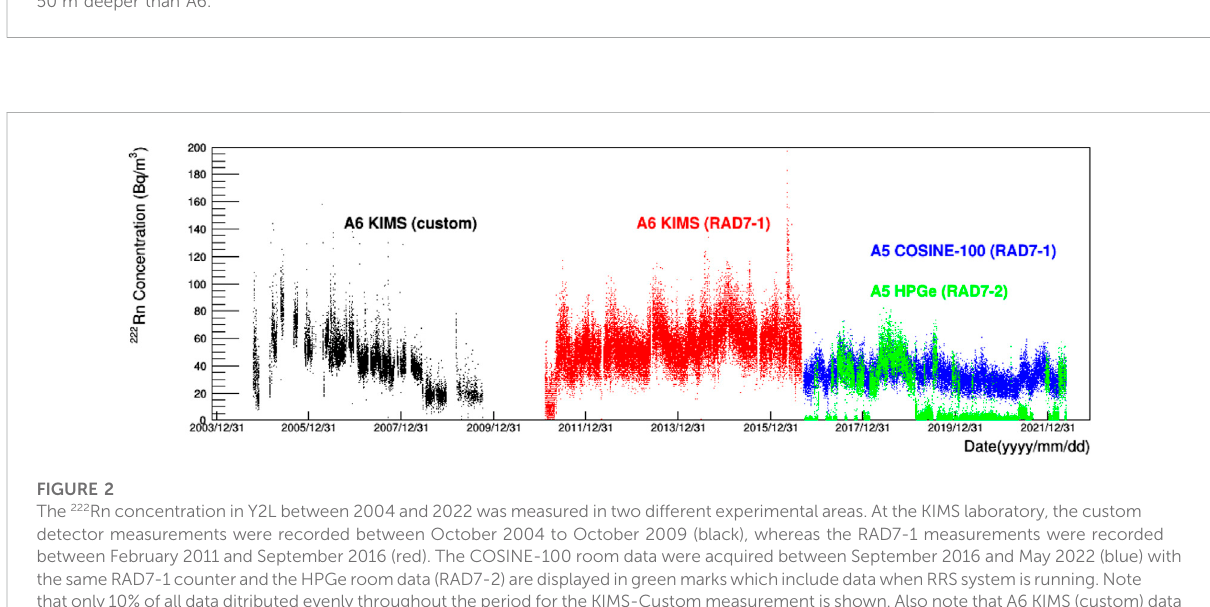
FIGURE 1 A map of Y2L. The experimental areas are accessed by vehicles through the main entrance. Since air is exhausted by fansat the end of themain tunnel, fresh air fl ows in a single direction. The KIMS experiment was located in the A6 tunnel, whereas the newer facilities are situated in the A5 tunnel, including the COSINE-100, AMoRE-I, and HPGe experiments. A5 and A6 are horizontally separated by 300 m, and A5 is approximately 50 m deeper than A6.